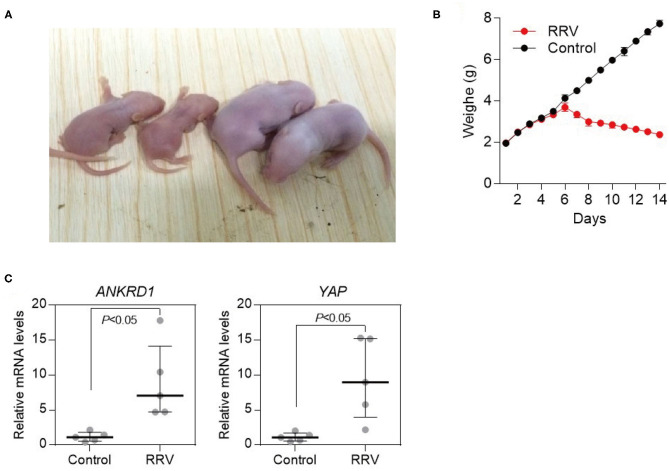
Increased YAP and ANKRD1 mRNA expression in an RRV-induced murine BA model. (A) RRV-induced BA model (age 2 weeks). Representative image of RRV-infected mice (left) and control (right). BA related symptoms, including reduced growth, jaundice, and oily fur were observed in RRV-infected mice. (B) Body weight of RRV-infected and control mice at different time points. Significant weight loss was observed in RRV-infected mice (n = 5). (C) Elevated expression of ANKRD1 and Yap mRNA in RRV-induced BA mouse livers (n = 5).